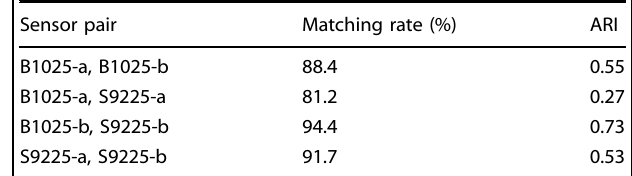
Table 3. Validity metrics for Experiment 3.